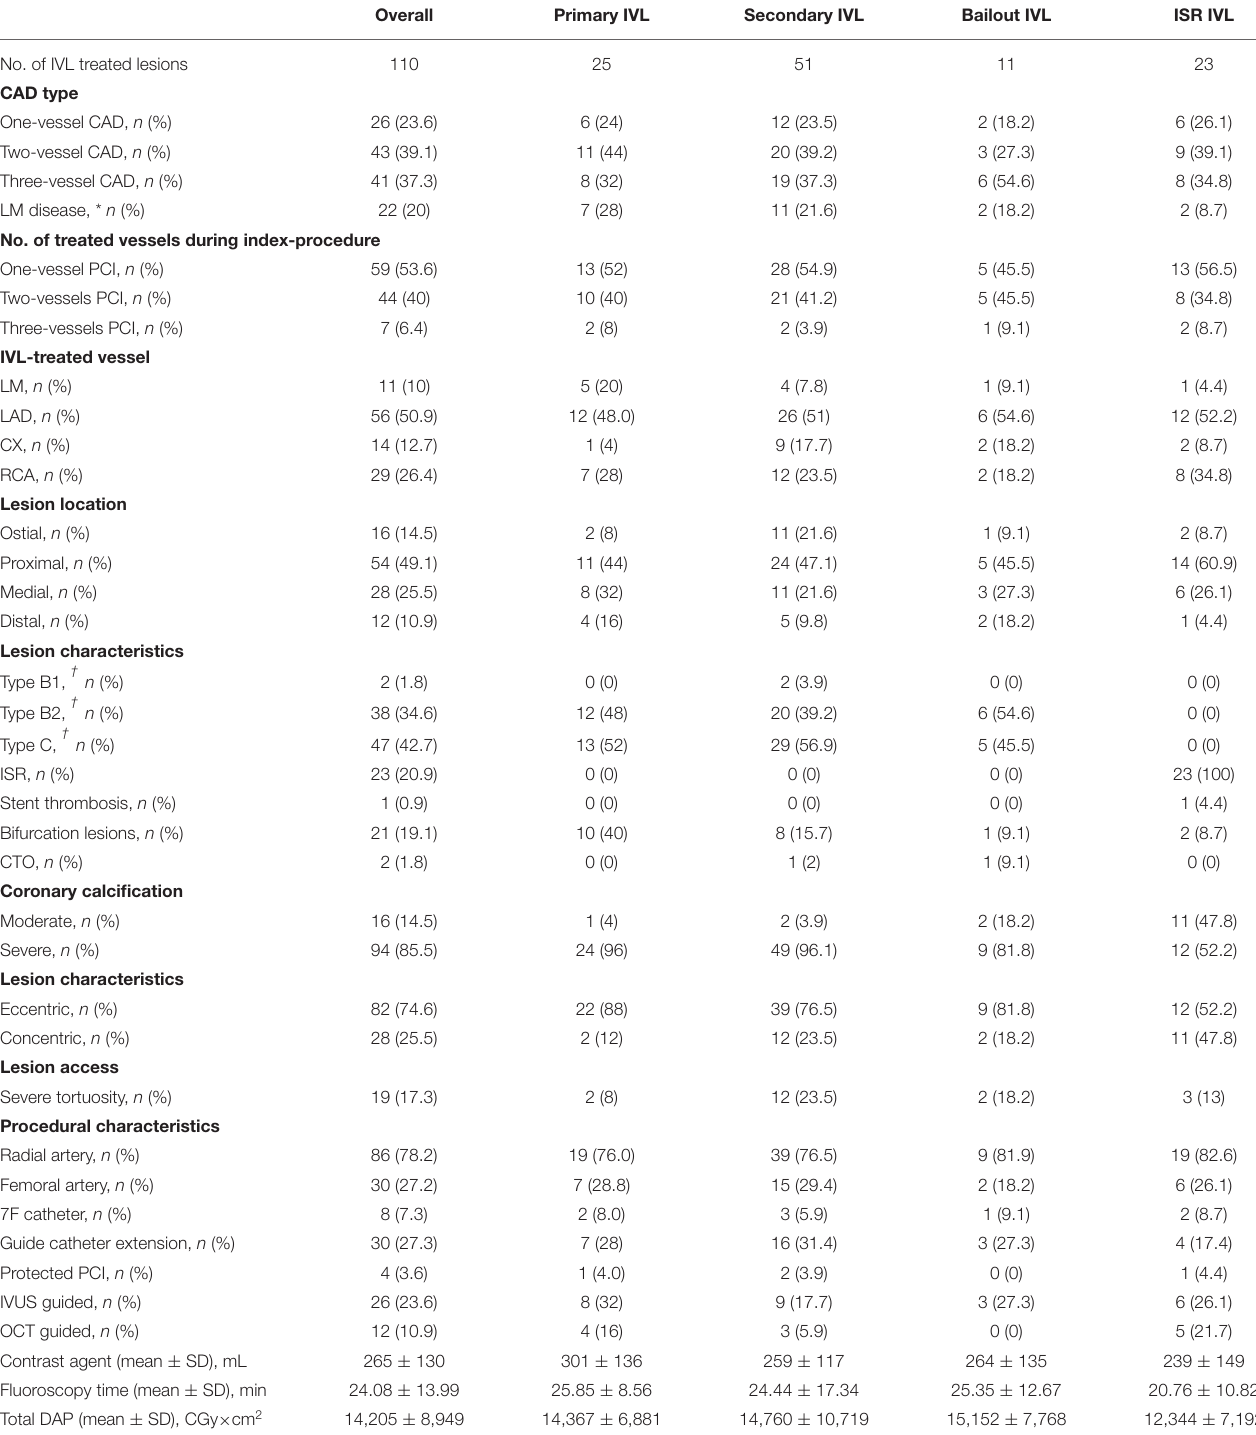
TABLE 2 | Lesions and procedural characteristics of the overall population and patient subgroups. Overall Primary IVL Secondary IVL Bailout IVL ISR